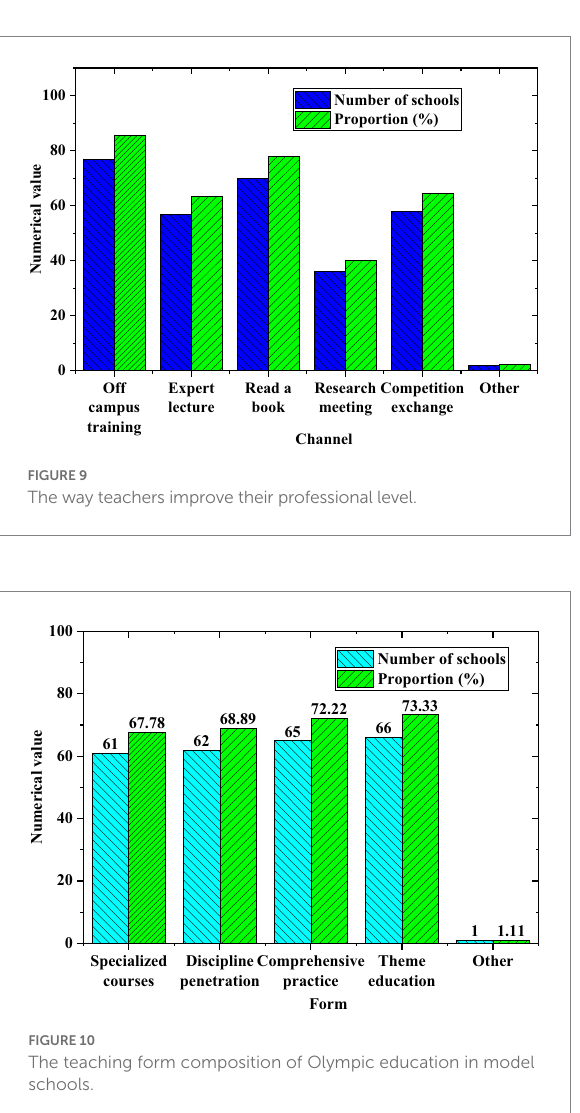
FIGURE 8 Teacher